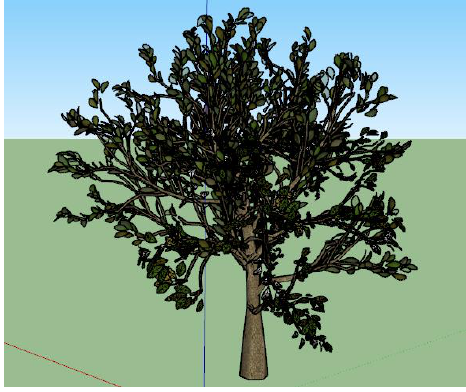
Figure 10. Final 3D mangrove